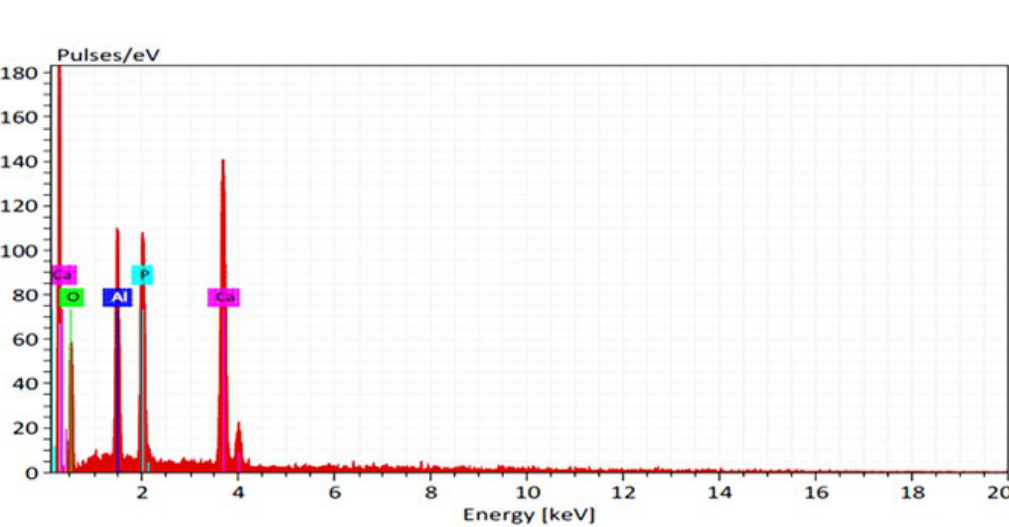
Fig. 7. EDX pattern of chitosan/hydroxyapatite nanocomposite: The Ca/P ratio of sample detected by EDX analysis, which was nearly similar to that of apatite (1.67) confirming CS/HA nanocomposite mimics the natural bone.